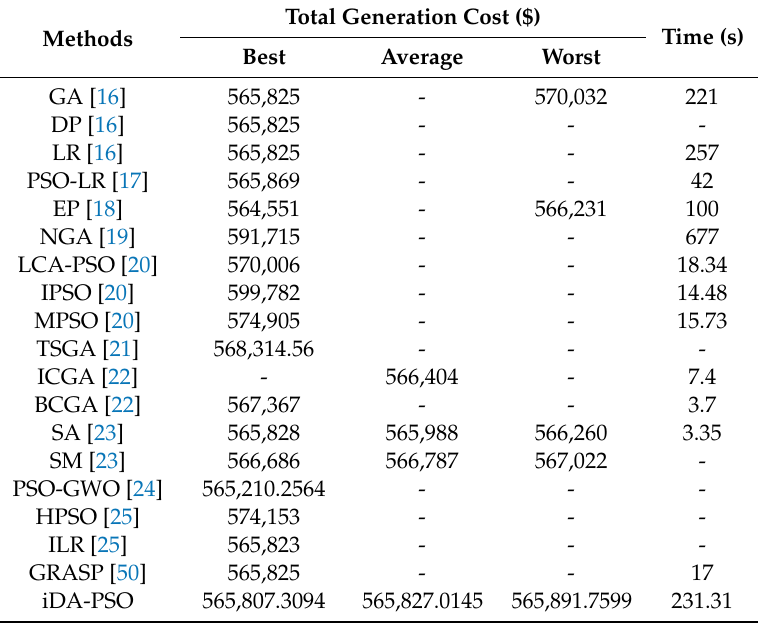
Figure 4. Convergence curve of the iDA-PSO approach for the 10-unit system. Table 12. Simulation results of the iDA-PSO approach compared with other algorithms in the literature for the 10-generating unit system.